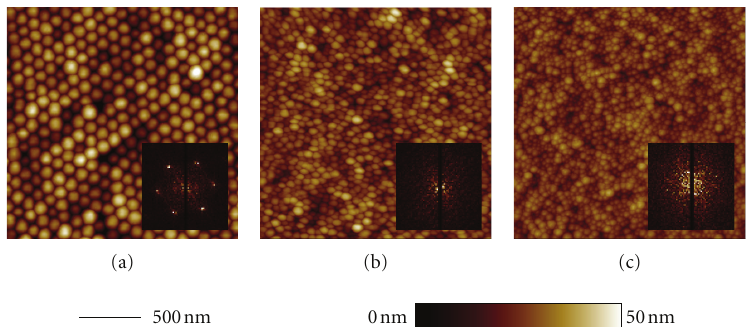
Figure 1: Tapping-mode AFM images of the top layer of a film obtained by slow solvent evaporation on freshly cleaved mica. (a) Image of the BPM4 specimen showing extreme regularity and very low dimension dispersion. In the inset, the 2D FFT showing distinct frequency peaks witnessing the high regularity of the hexagonal close-packed layer (FFT maxima measure an approximately 100 nm distance between particles). The direct-space measurement of the closest interparticle distances on a set of particles shows a (108 ± 8)nm distance (average ± standard deviation); (b) same as above on the BPM6 specimen, showing a markedly lower order in the layer (the 2D FFT, in the inset, does not show any distinct maxima). Direct-space measurements of closest interparticle distances report a (46 ± 25)nm distance, also witnessing a higher dimensional dispersion on the particle dimensions and packing; (c) same as above for the BPM10 specimen. Closest interparticle distances (54 ± 25)nm with a low order multilayer (2D FFT in the inset with no distinct maxima). The size and relative heights of the micrographs are displayed according to the attached size bar and colormap.